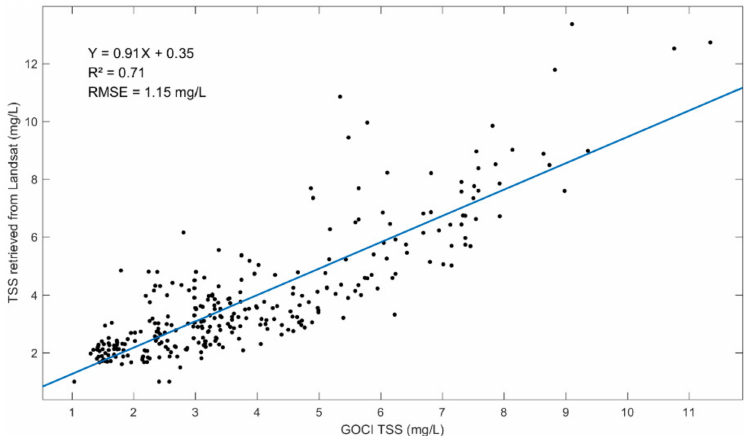
Figure 6. Comparison between TSS data from GOCI and